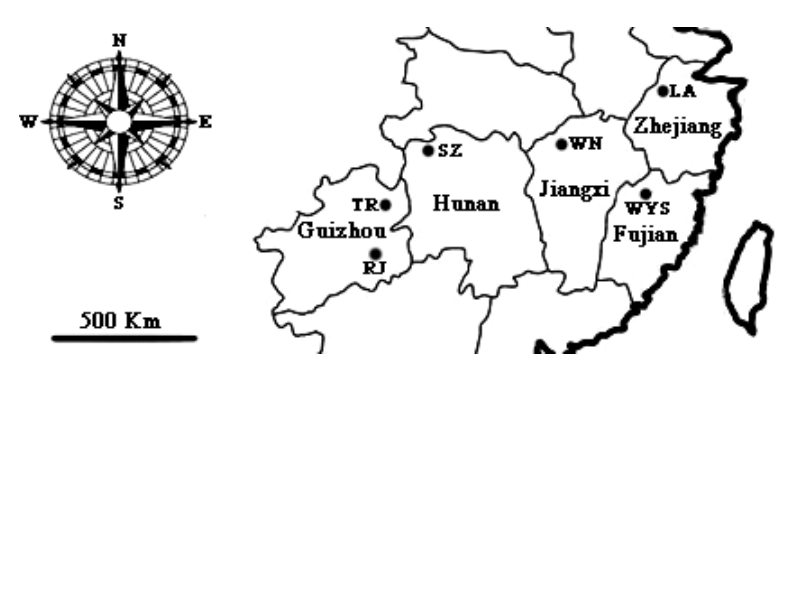
Figure 5. Map of six sampled populations of C. tsoongiana in